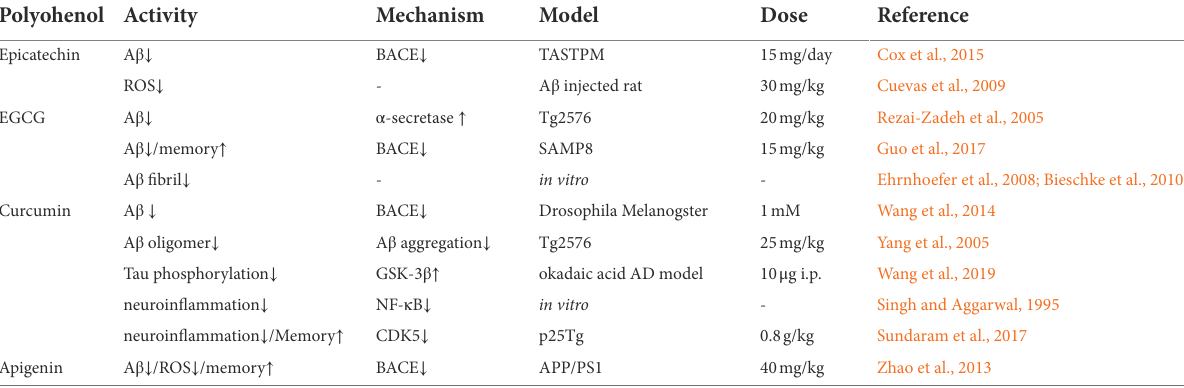
TABLE 1 Role of polyphenols in modulating AD-type